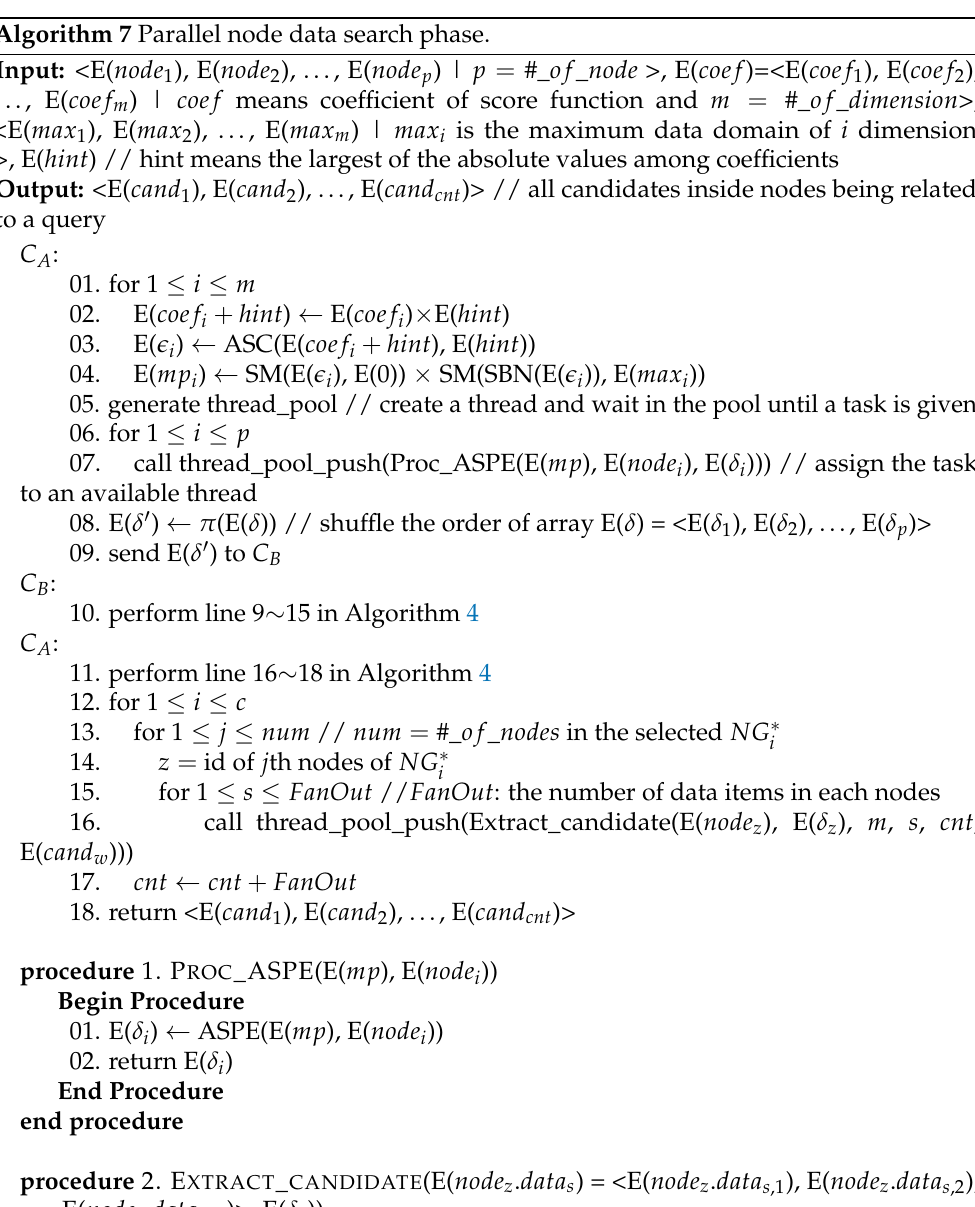
Algorithm 7 Parallel node data search